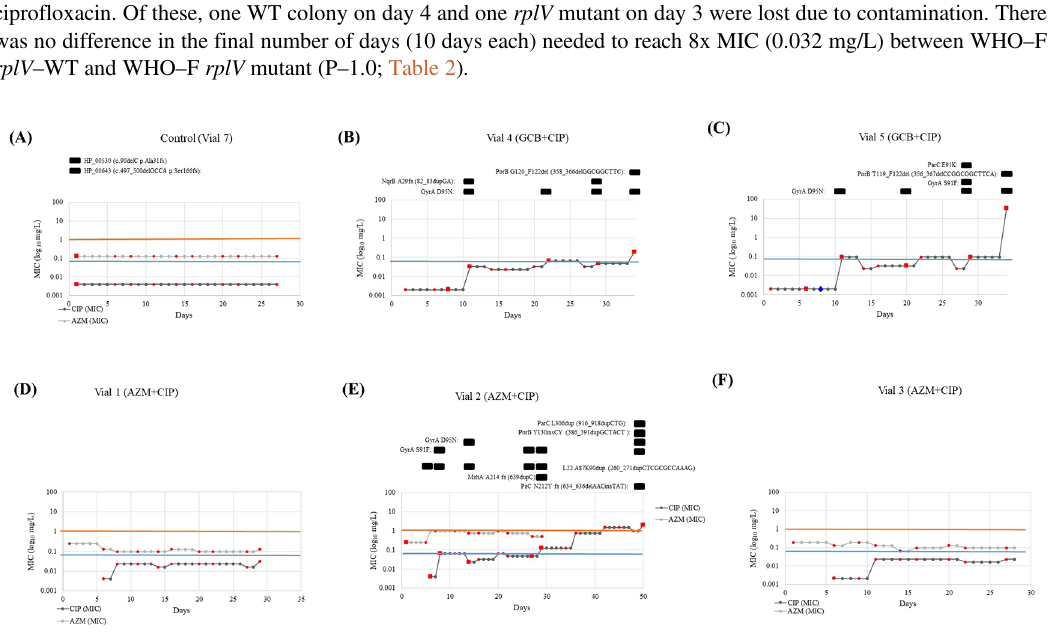
Figure3.RepresentationoftheciprofloxacinandazithromycinMICevolutionofthevialsfromeachcondition andthecontrol. Vial6(GCB+CIP)isnotdepictedbecausethecoloniesdidnotsurvivepastday6-afterfirstexposure to CIP. The red markers show at which days samples were taken and the colored lines represent the MIC threshold